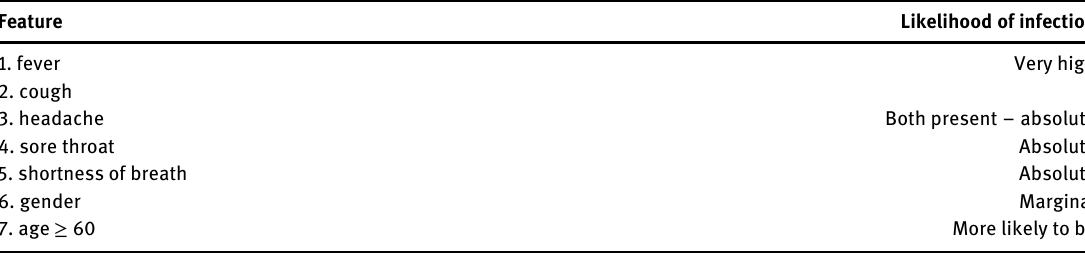
Table 4: A check list for triage of patients seen for possible COVID_19 infection.